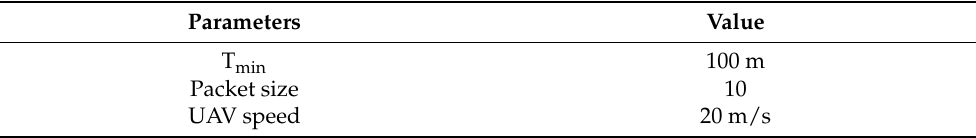
Table 2. Connectivity Routing Algorithm.